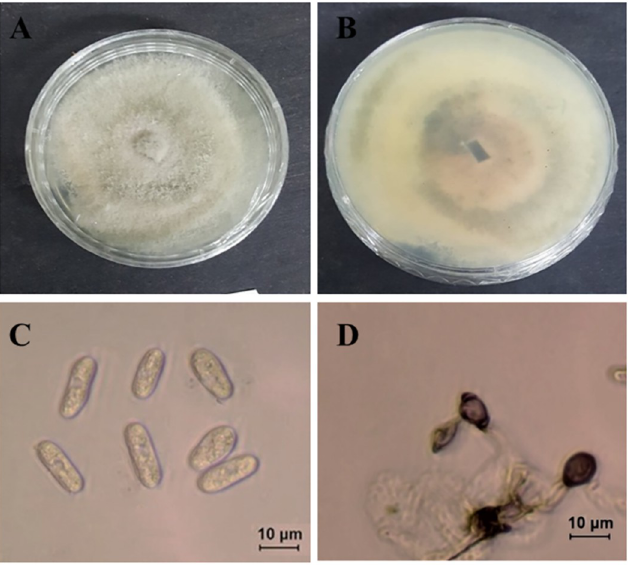
Fig 14. Morphological characteristics of C . sojae (isolate M72). A-B: Colony on PDA above and below. C: Conidia. D: Appressoria.